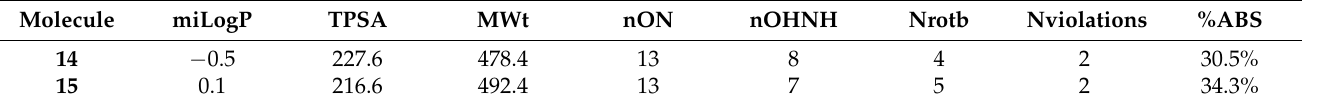
Table 2. Predicted physiochemical parameters of the best identified compounds and their structural descriptors.